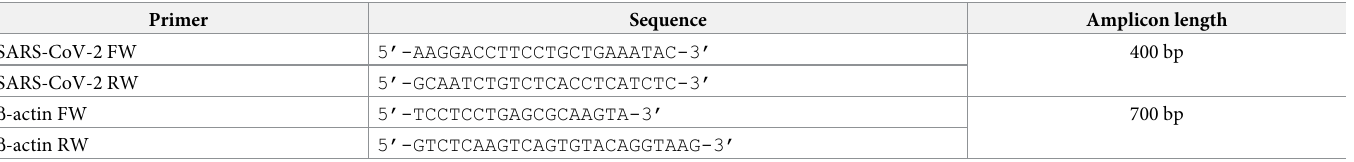
Table 1. Sequences of primers employed. All primers were designed using PrimerQuest Tool (IDT) and purchased from IDT. Lyophilized primers were resuspended in DNAse/RNAse free water (Sigma-Aldrich) at a stock concentration of 1 μ gr/ μ l, a further dilution was performed before the PCR preparation reaching a primers final con- centration of 50 ng/ μ l, in nuclease-free